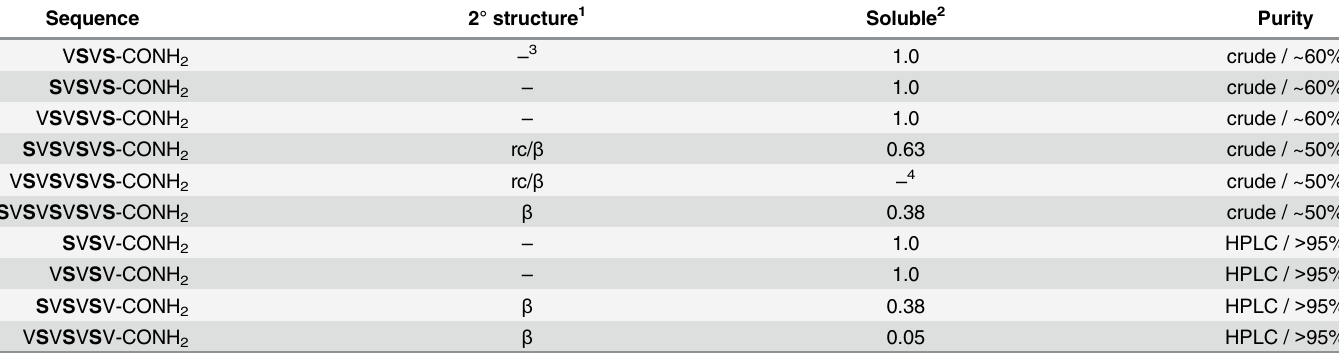
Table 1. Solubility and secondary structure of binary alternating peptides.